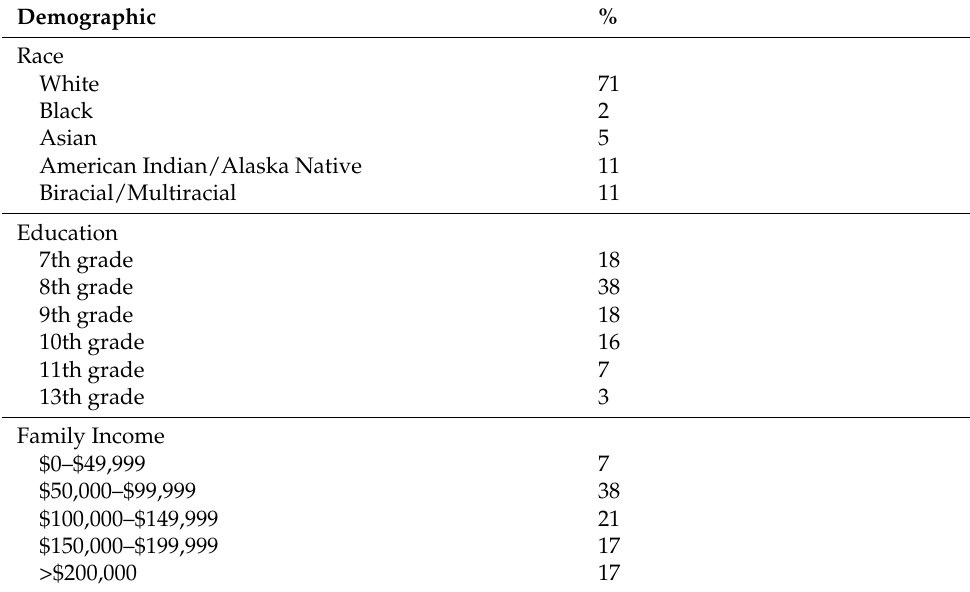
Table 1. Sample demographic information.